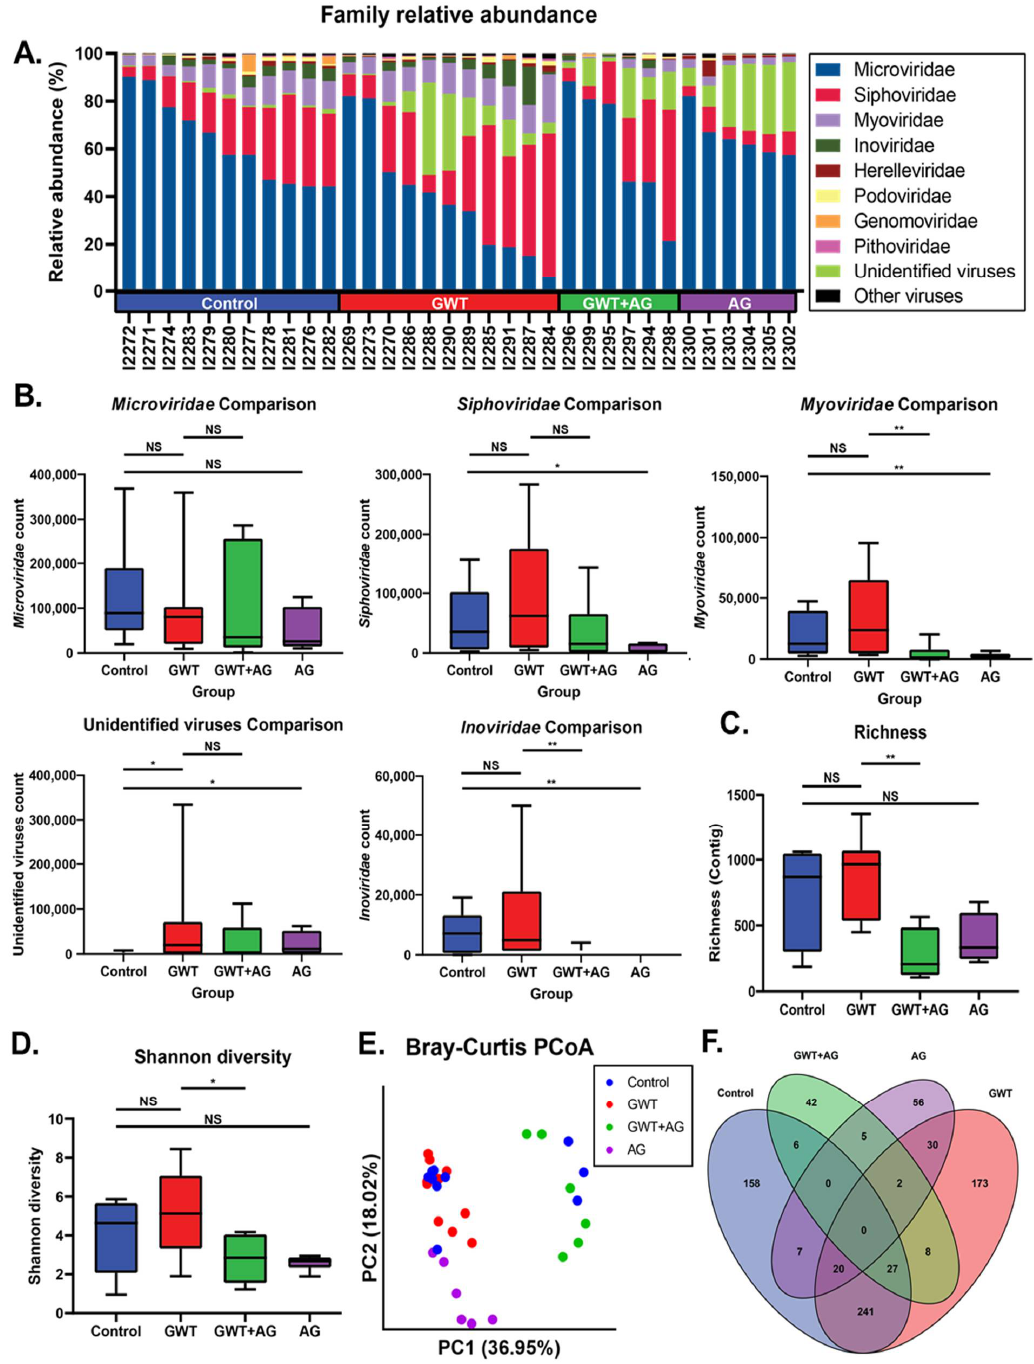
Figure 2. Virome composition and analysis of mice under different GW chemical exposure conditions. ( A ) Relative abundance of most abundant viral families for all mice in the cohort. ( B ) Boxplots of Microviridae, Siphoviridae, Myoviridae, and Inoviridae NGS RPK counts between treatment groups. Statistical significance was assessed by a Mann–Whitney U test (* p < 0.05, ** p < 0.01, NS: non-significant). ( C ) Boxplot of viral contig richness between treatment groups. Statistical significance was assessed by Mann–Whitney U test (** p < 0.01, NS: non-significant). ( D ) Boxplot of Shannon diversity between treatment groups. Statistical significance was assessed by Mann–Whitney U test. (* p < 0.05, NS: non-significant) ( E ) Principal coordinate analysis plot of Bray–Curtis distances of samples colored by treatment group. ( F ) Venn diagram of LEfSe analysis of pairwise comparisons between treatment groups. Overlapping regions indicate shared discriminant features between